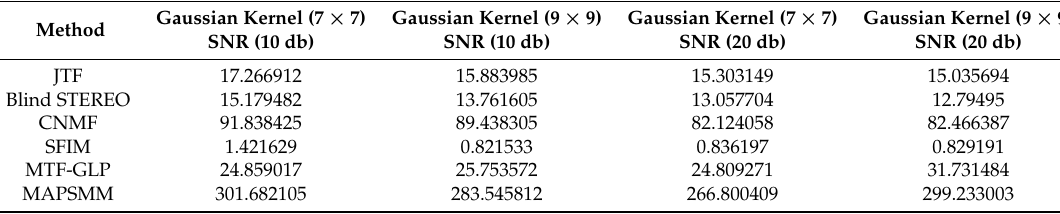
Table 2. Time (s) of the test methods on Pavia University under the different conditions.